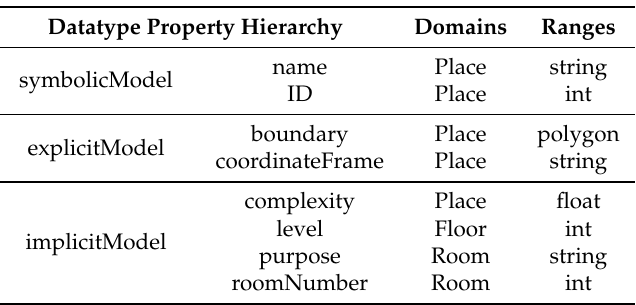
Table 4. Datatype properties for Place .